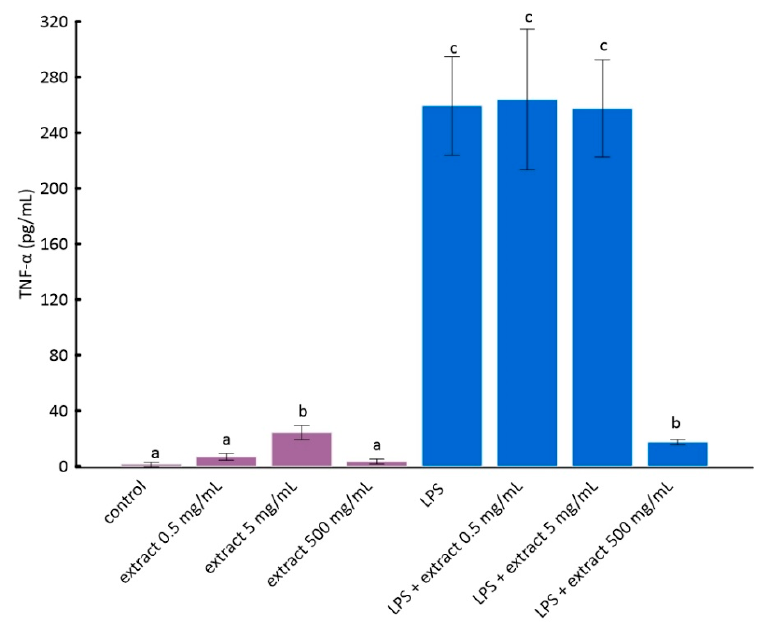
Figure 3. The influence of aronia extract on lipopolysaccharide-induced production of tumor necrosis factor α . The values are means ±SD. The same letter (a, b, and c) indicates that there is no statistically significant difference between the analyzed samples at a confidence level of p < 0.05. The different letter indicates the significant difference ( p < 0.05) among the mean values. The results are ordered as follows: a < b < c.